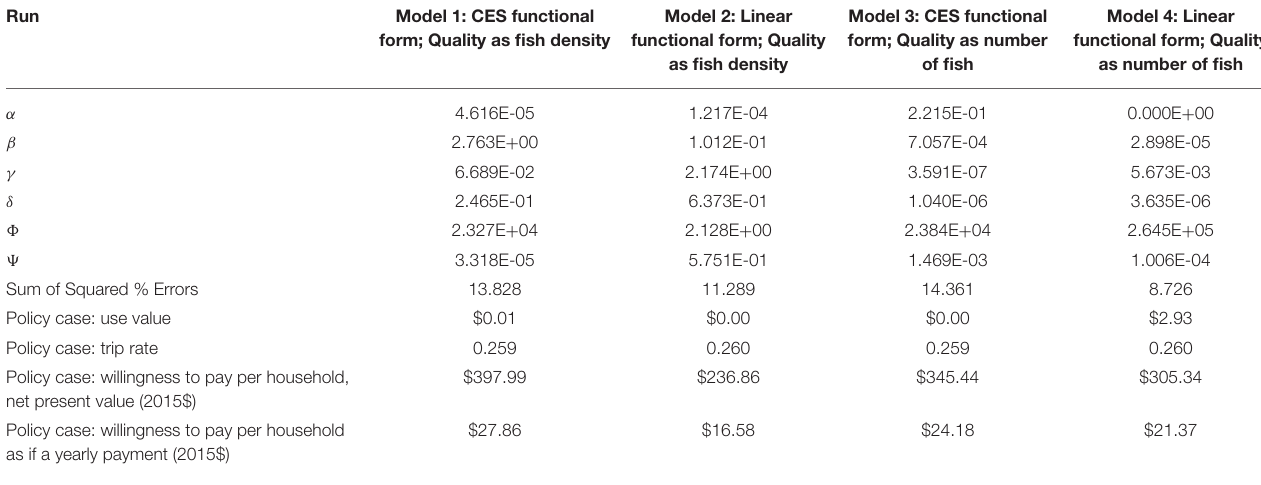
TABLE 6 | Structural benefit transfer calibrated parameters and predicted